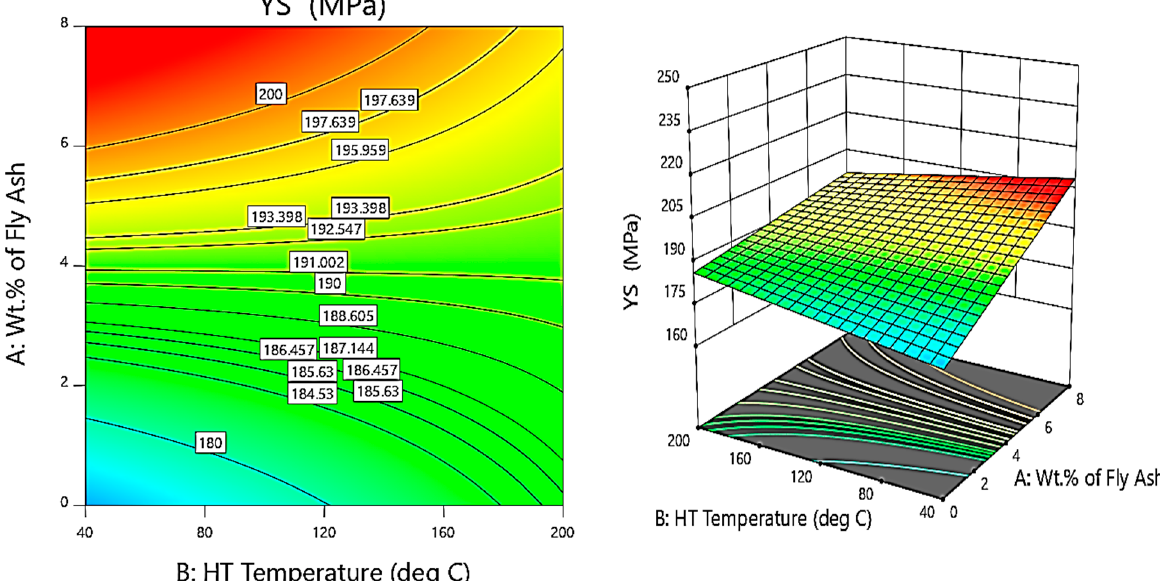
Figure 16. Contour and 3D Surface plots for variation of YS with varying wt.% of fly ash and HT temperature.